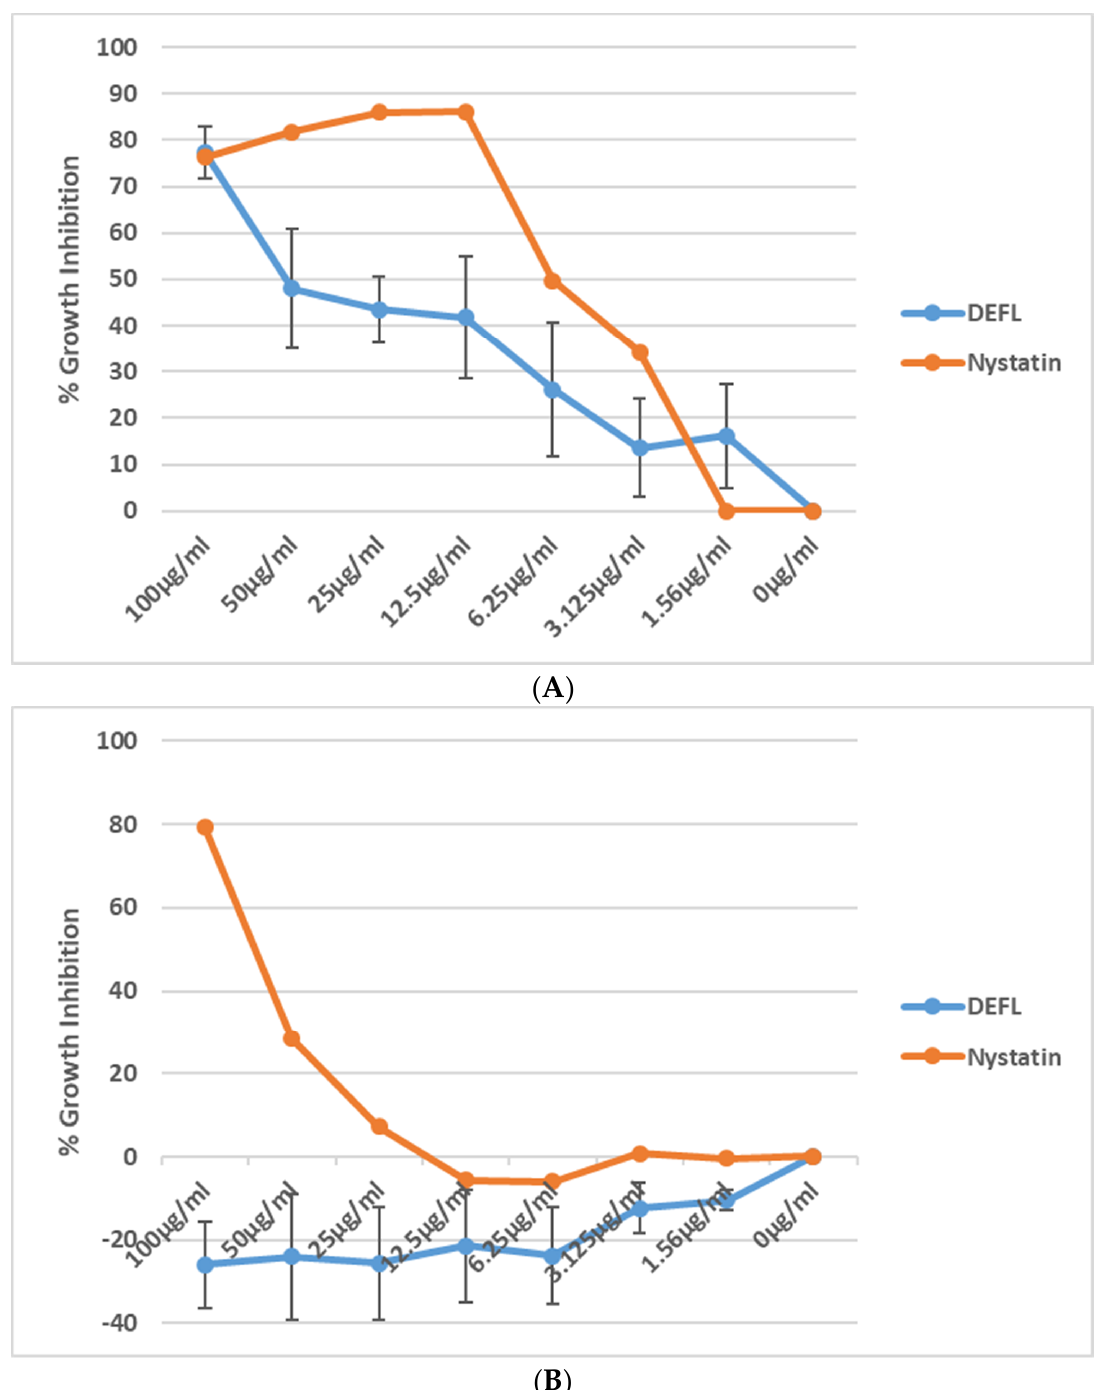
Figure 11. Antifungal activity of the At3g59930 peptide. ( A ), B. cinerea and ( B ), F. oxysporum . Shown is percent growth inhibition with standard deviation after 48 h against peptide concentrations ranging from 1.56 μg/mL to 100 μg/mL. The fungicide nystatin was used as a control. At3g59930 had no activity against F. oxysporum but was active against B. cinerea with an IC 50 of approximately 50 μg/mL.